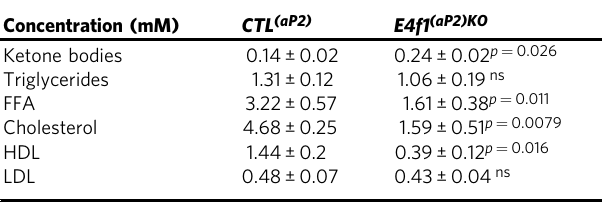
Table 1 Metabolic characterization of mice lacking E4F1 in their adipose